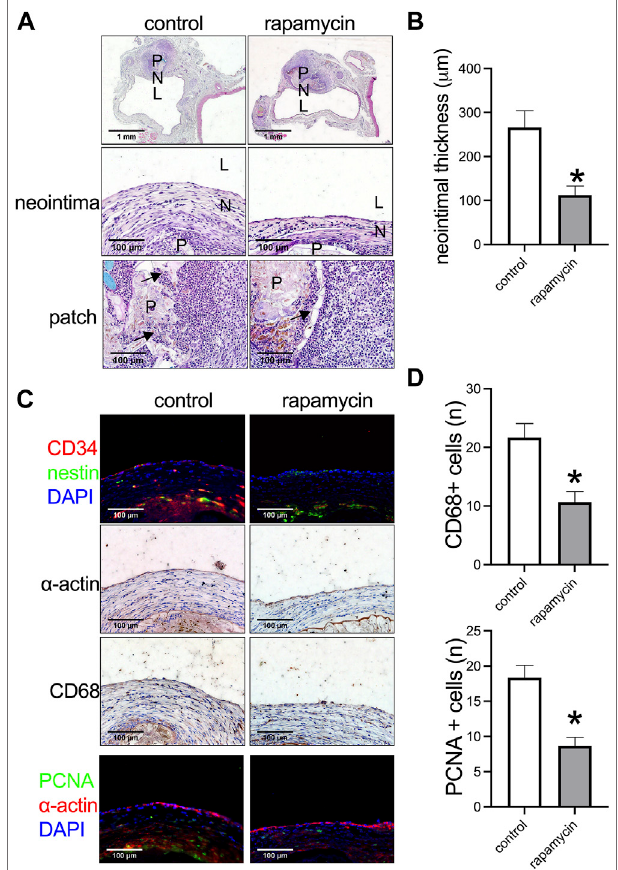
FIGURE 3 | Rapamycin-absorbed plant leaf decreased neointimal thickness and neointimal hyperplasia after patch venoplasty in rats. (A) Photographsofthepatchstainedwithhematoxylinandeosin(H&E)atday 14; P, patch; L, lumen; N, neointima; n (cid:2) 3 – 5. (B) Bar graph showing the venoplasty neointimal thickness, *, p (cid:2) 0.0231, t-test, n (cid:2) 3. (C) Immuno fl uorescence stained for CD34 (red), nestin (green), and DAPI (blue) in the neointima; immunohistochemistry stained for α -actin and CD68 in the neointima; immuno fl uorescence stained for PCNA (green), α -actin (red), and DAPI (blue) in the neointima; scale bar 100 μ m; n (cid:2) 3. (D) Bar graphs showing the CD68 positive cells (*, p (cid:2) 0.0210, t-test) and PCNA positive cells in the neointima (*, p (cid:2) 0.0106, t-test); n (cid:2)